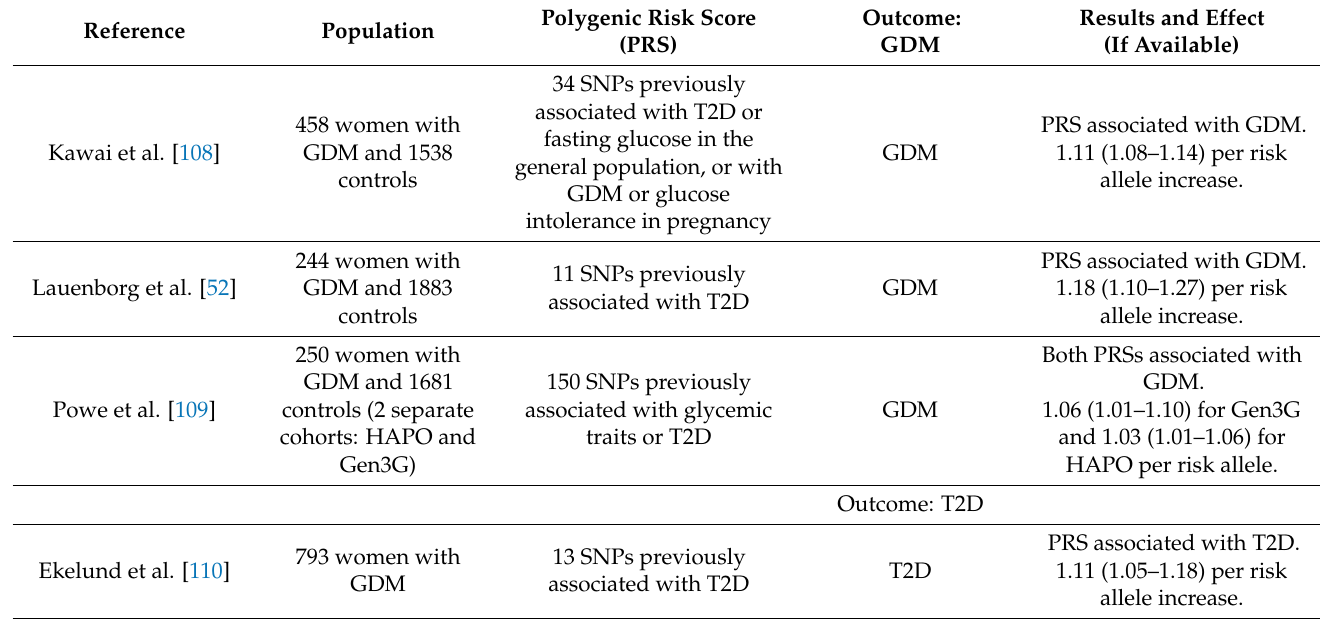
Table 2. Polygenic risk scores studied in women with gestational